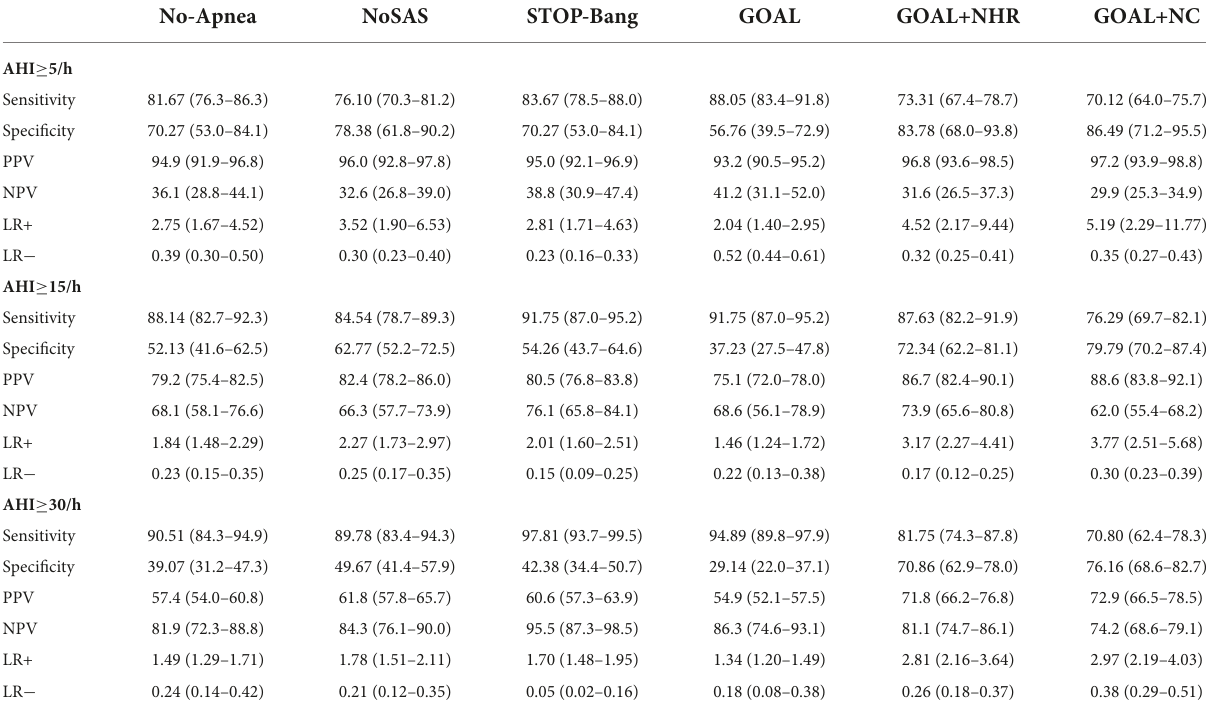
TABLE 2 Performance of the screening tool at different apnea-hypopnea index (AHI)